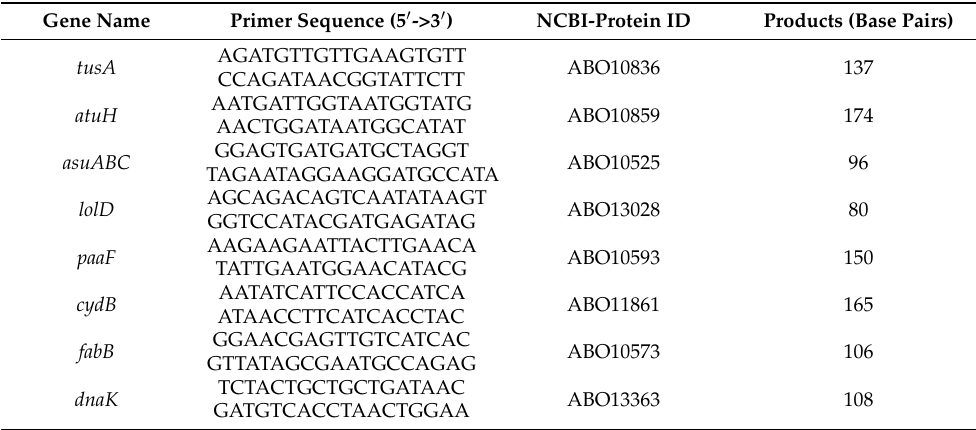
Table 2. Primer sequences used for quantitative real-time polymerase chain reaction (RT-PCR).